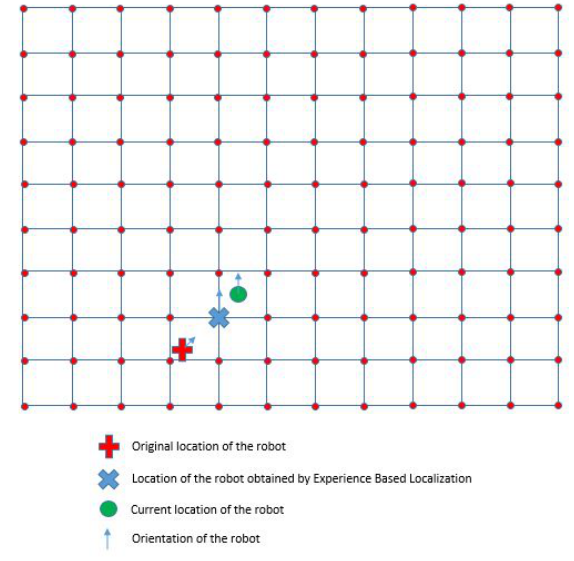
Figure 10: Flowchart of experience based localization. This figure shows the process of experience based localization for robot pose